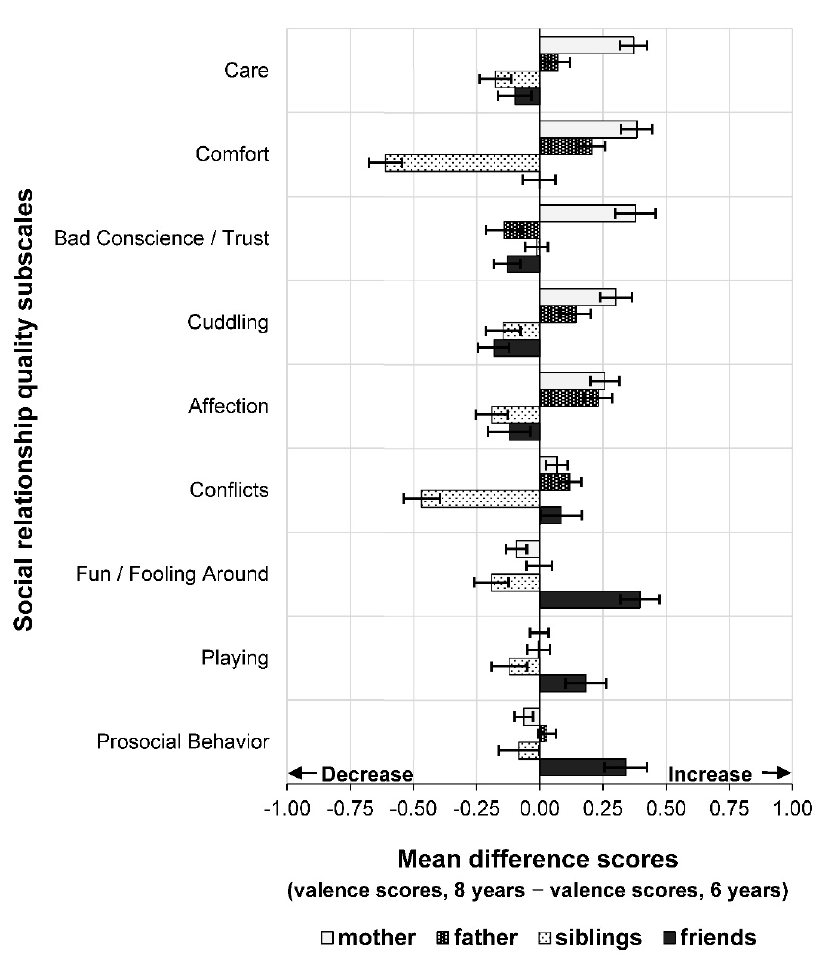
Figure 2. Mean-level changes in social relationship quality subscales between 6 and 8 years according to social relationship types ( N = 1110). Mean difference scores were obtained by subtracting valence scores at 6 years from valence scores at 8 years (i.e., Time 2 minus Time 1). Error bars represent 95% confidence intervals. The subscale Conflicts is inverted, negative values indicate an increase in conflicts and positive values indicate a decrease in conflicts.